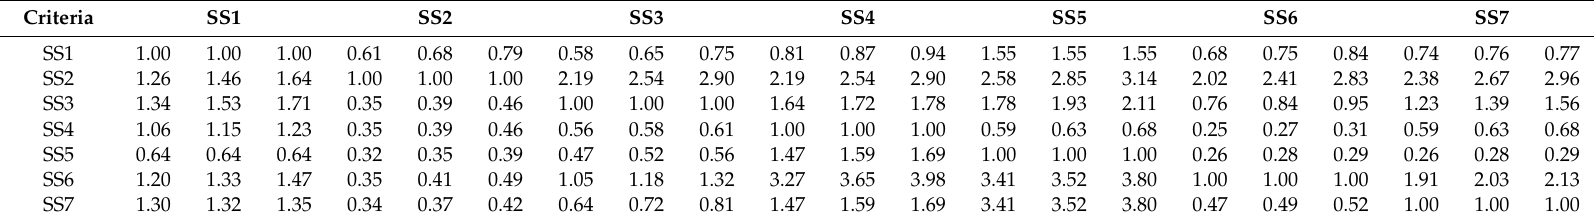
Table 4. Pairwise comparison matrices for all respondents.